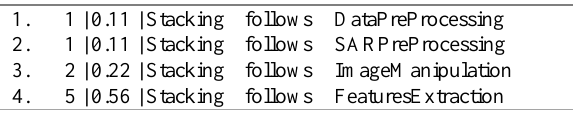
Table 4 Code sample of Stacking operations type